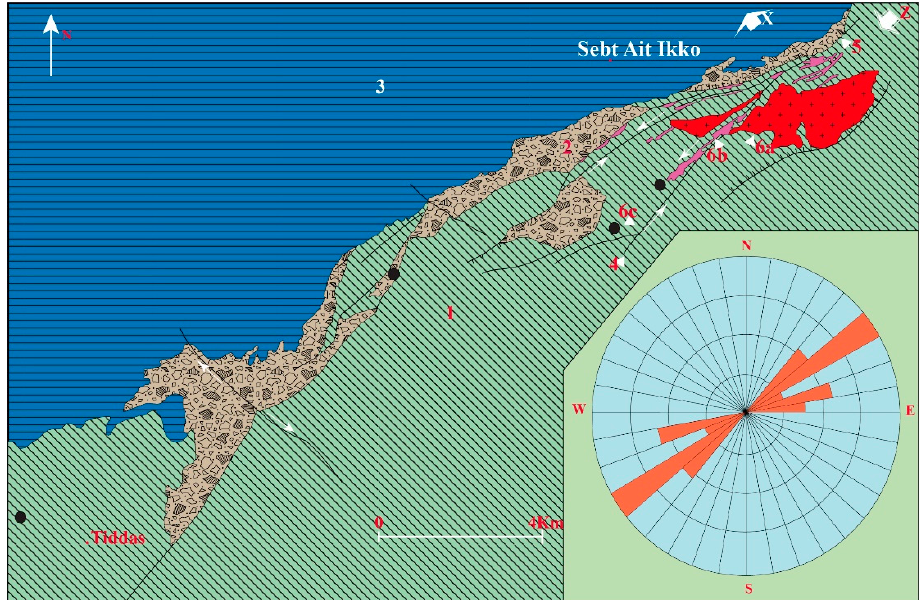
Figure 18. Structural control of emission centers in the Permian volcanics of the TSESDAI volcanic complex: (1) Pre-Permian Paleozoic basement; (2) Autunian conglomerates, sandstones, and mudstones; (3) Mesozoic and Tertiary formations; (4) left-lateral fault; (5) normal faults; (6) emission centers, domes (6a), veins (6b), and maximum thickness of flows (6c). Z, direction of shortening; X, direction of extension. The inlet displays a rosette of the directions and cumulative lengths of the rhyolitic